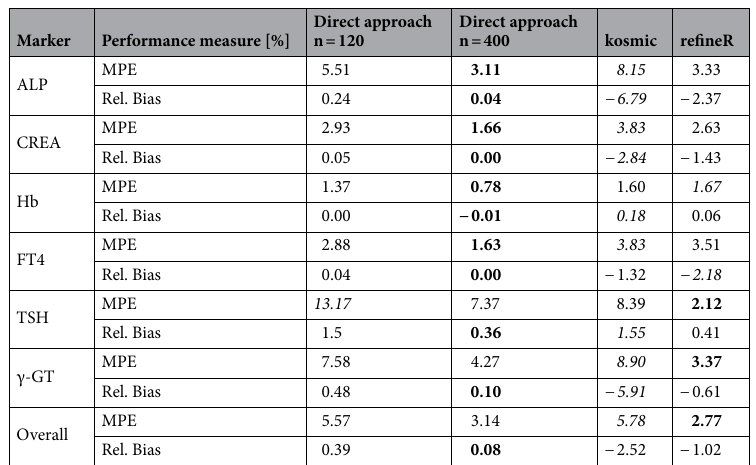
Table 3. Mean percentage error and relative bias for each simulated analyte and overall. The table shows for each analyzed test case the calculated performance measurements for all considered methods (direct method with n = 120 and n = 400, kosmic and refineR algorithm). The performance for each individual test case as well as the mean performance over all six test cases are shown.Values in bold represent the best result per biomarker (smallest MPE/Rel. Bias closest to zero), while the values in italics represent the worst result (largest MPE/Rel. Bias farthest from zero). MPE mean percentage